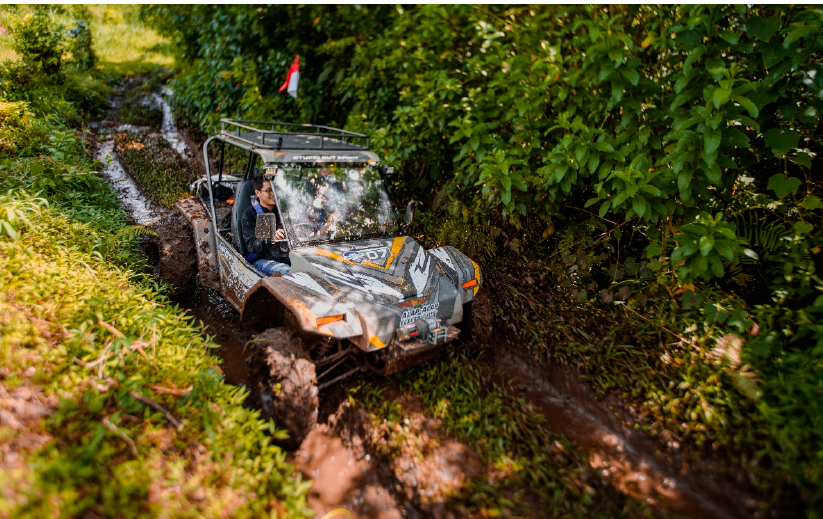
Figure 20. Off-road vehicle as the controller platform implementation.